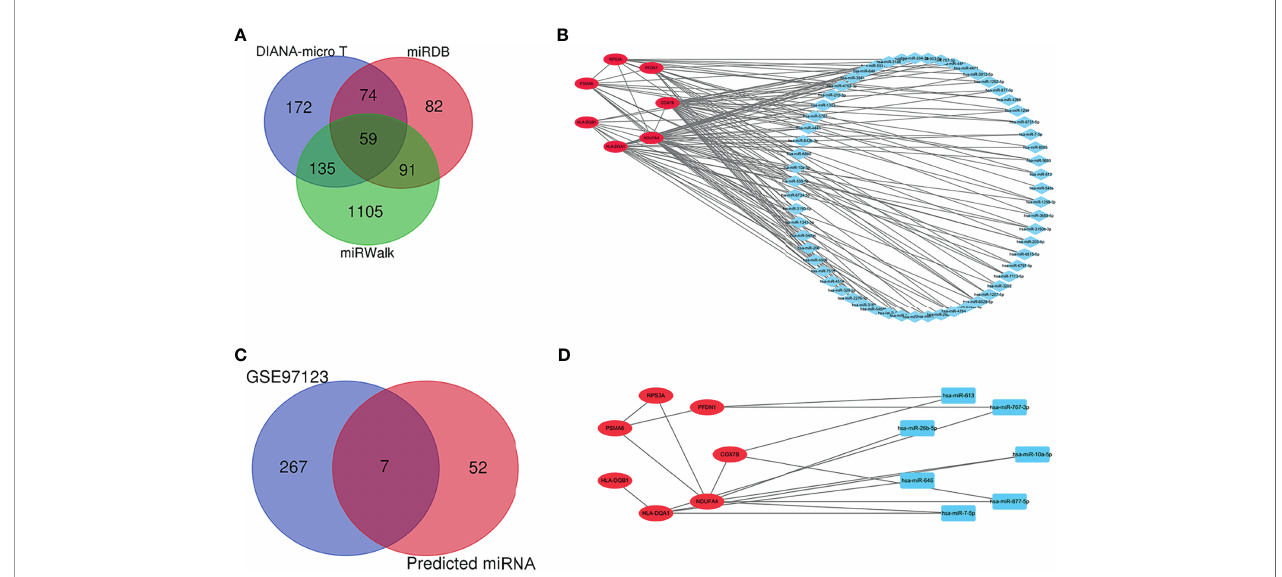
FIGURE 6 | Prediction and validation of target miRNA. (A) Venn diagram showing the numbers of predicted miRNAs based on the DIANA-micro T, miRDB, and miRWalk online databases. (B) The relationship between 7 hub genes and 59 miRNAs (miRNA – mRNA regulatory network). (C) Venn diagram showing the intersection between predicted miRNAs and DEmiRNAs in T1DM patients from the GSE97123 dataset. (D) The relationship between seven hub genes and seven validated miRNAs (miRNA – mRNA regulatory